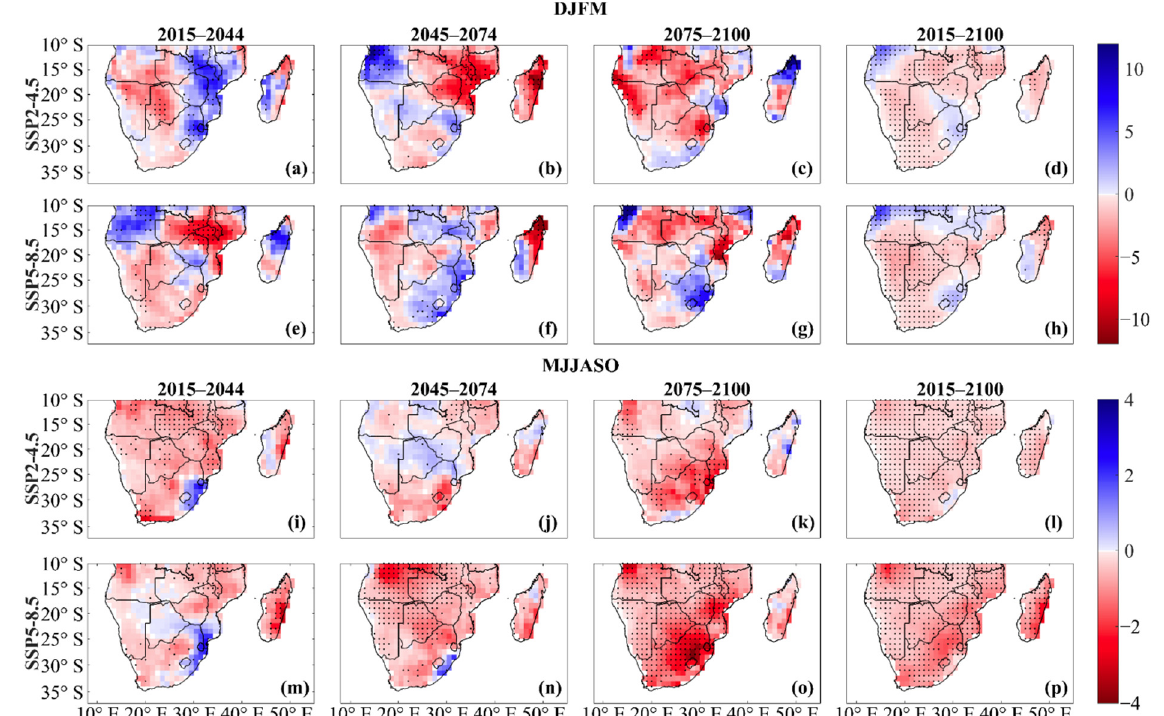
Figure 10. Spatial distribution of projected seasonal precipitation trends (mm/decade) over Southern Africa, under ( a – d , i – l ) SSP2-4.5 and ( e – h , m – p ) SSP5-8.5 scenarios, during 2015–2044 (near future), 2045–2074 (mid-future), 2075–2100 (far future) and 2015–2100 (total period). ( a – h ) DJFM and ( i – p ) MJJASO. Red and blue tones represent an upward and downward trend, respectively. The black dots denote grids significant at a 95% confidence level.